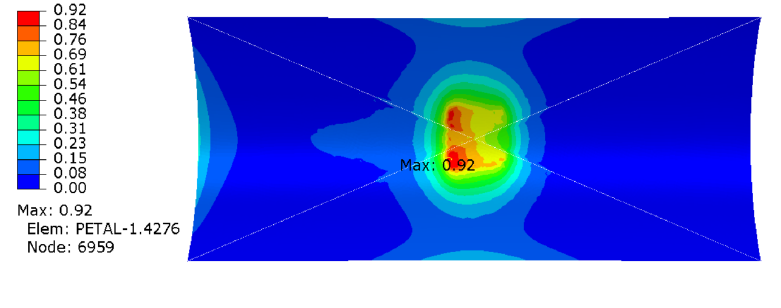
Figure 17. Tsai–Wu failure criterion in the critical composite layer of the load-bearing